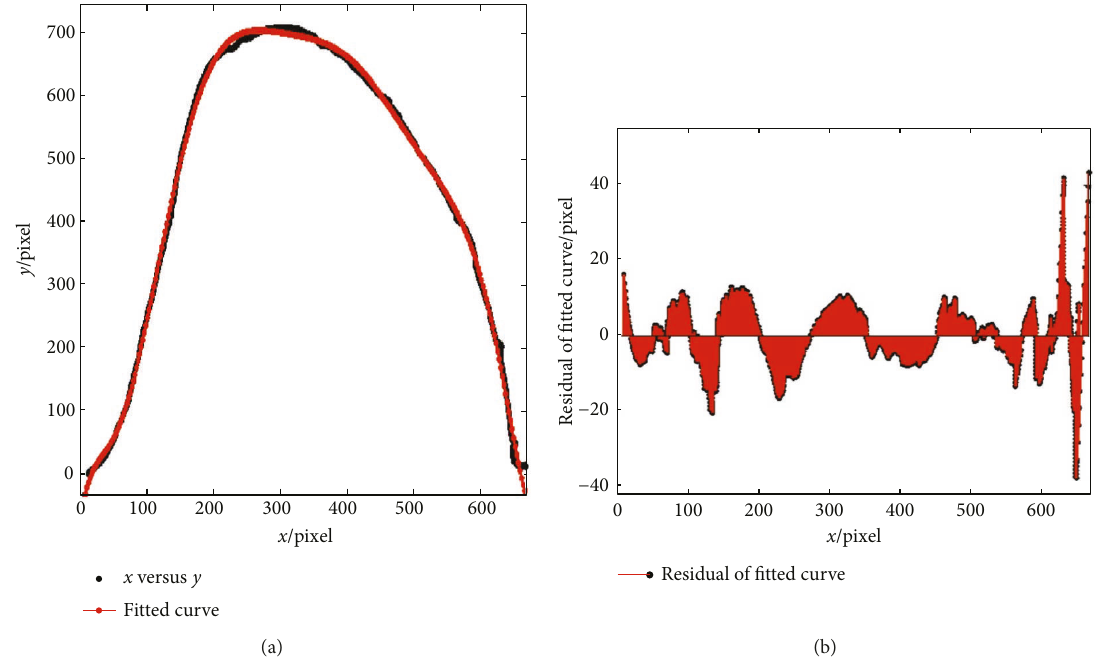
Figure 6: Extracted outer margin of the end-tooth. (a) Two-dimensional point cloud and fi tted curve of the end-tooth. (b) Residual of the fi tted curve.